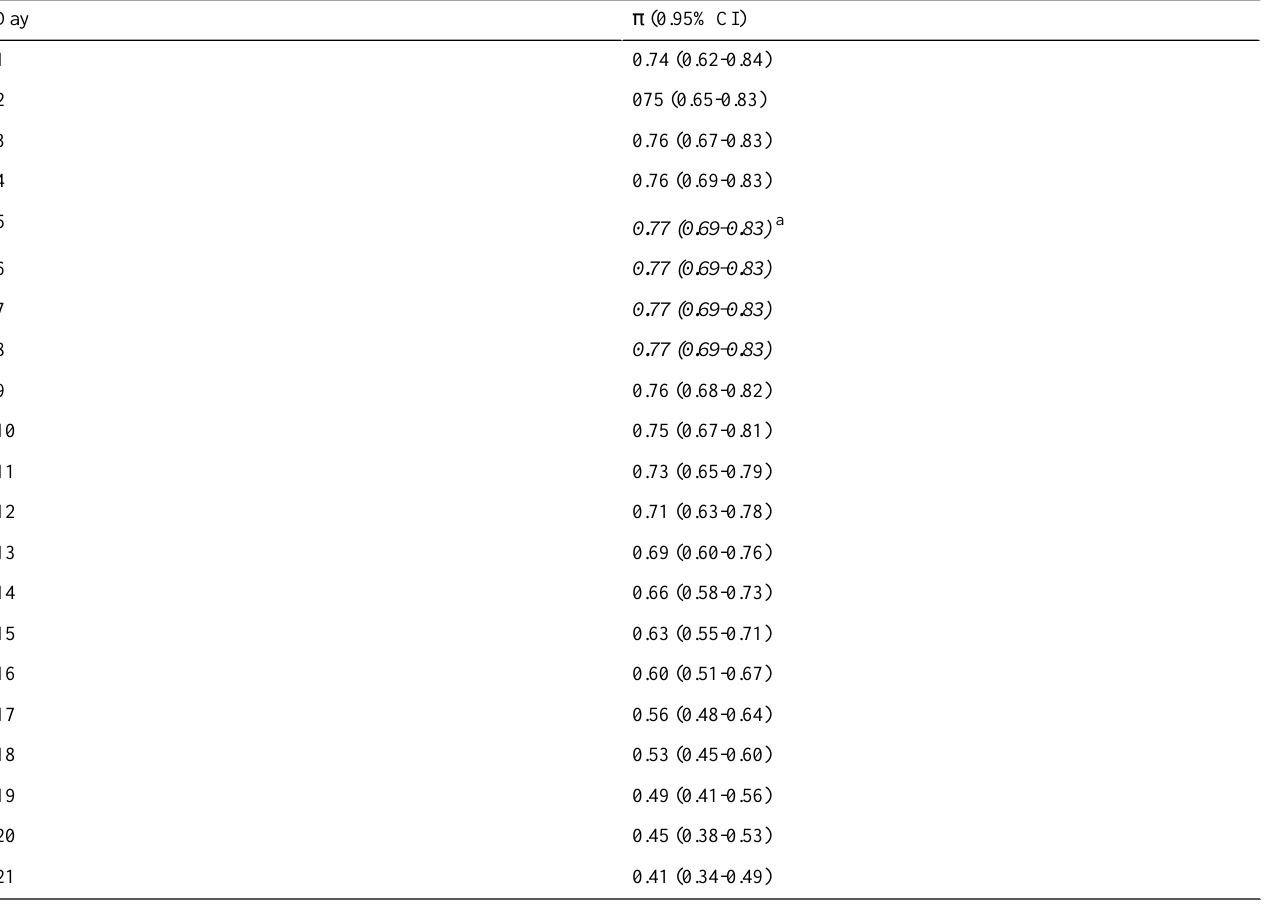
Table 2. Predicted probabilities of the generalized additive mixed models for a positive swab test result related to the number of days since close contact in the whole group of infected health care workers at the University Hospital of Verona (model was fitted with data collected between February 29